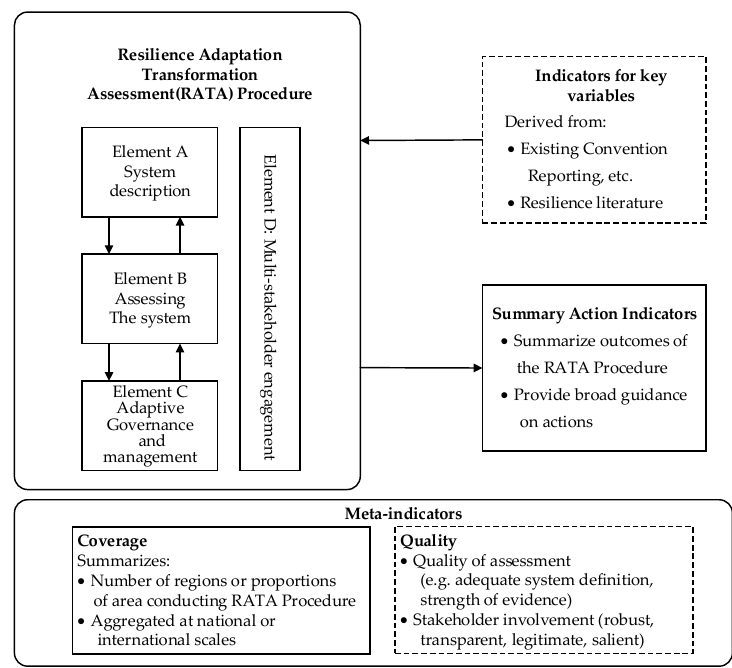
Figure 3. The resilience, adaptation and transformation assessment and learning framework. Source: O’ConneH, et al. 2015 [45]. Table 1. List of hierarchical structure, and indicator descriptions. The Target